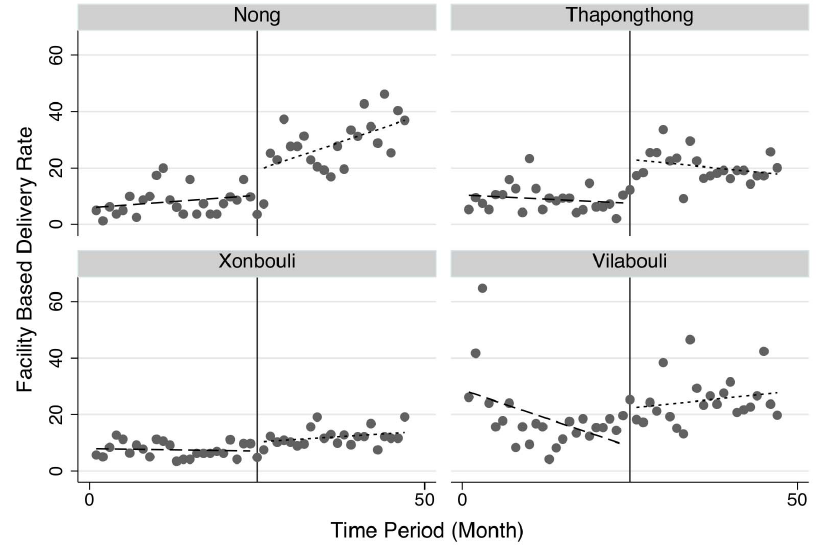
Figure 4. Facility-Based Deliveries in Pilot and Non-Pilot Districts.